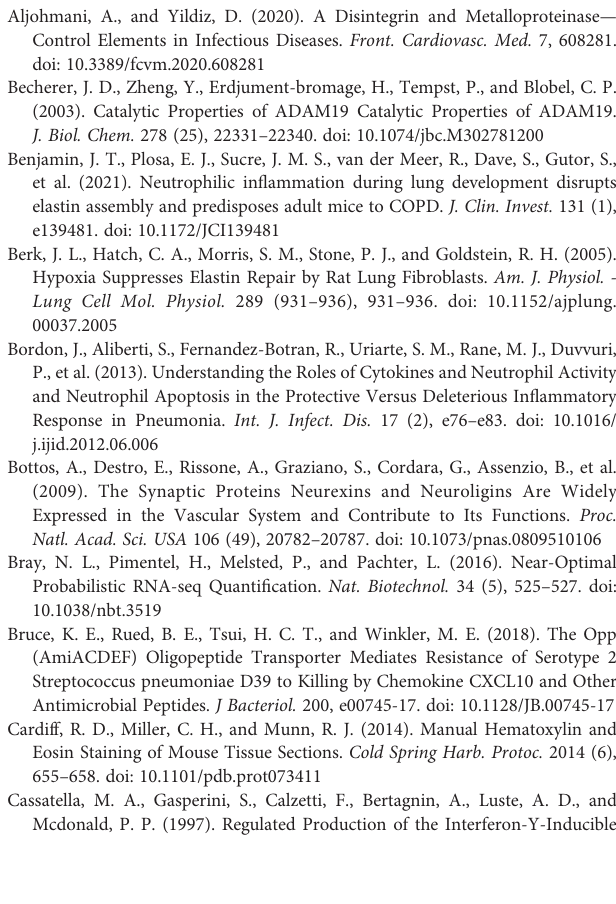
deviation (error bars).